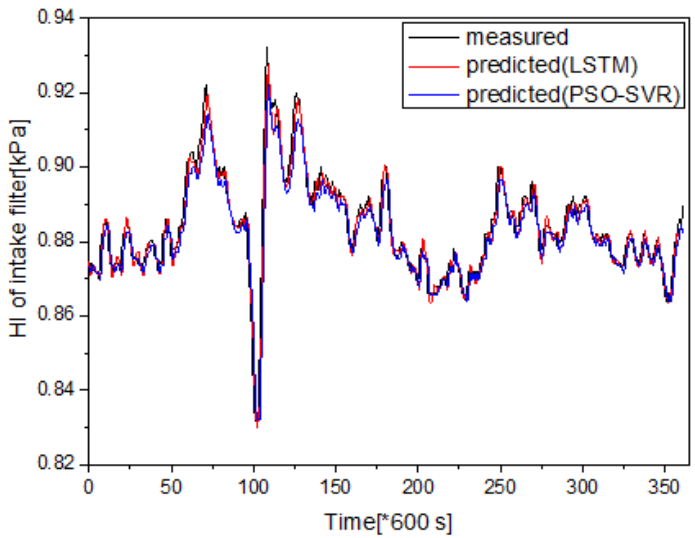
Figure 9. Comparison curves of performance degradation predicted results.